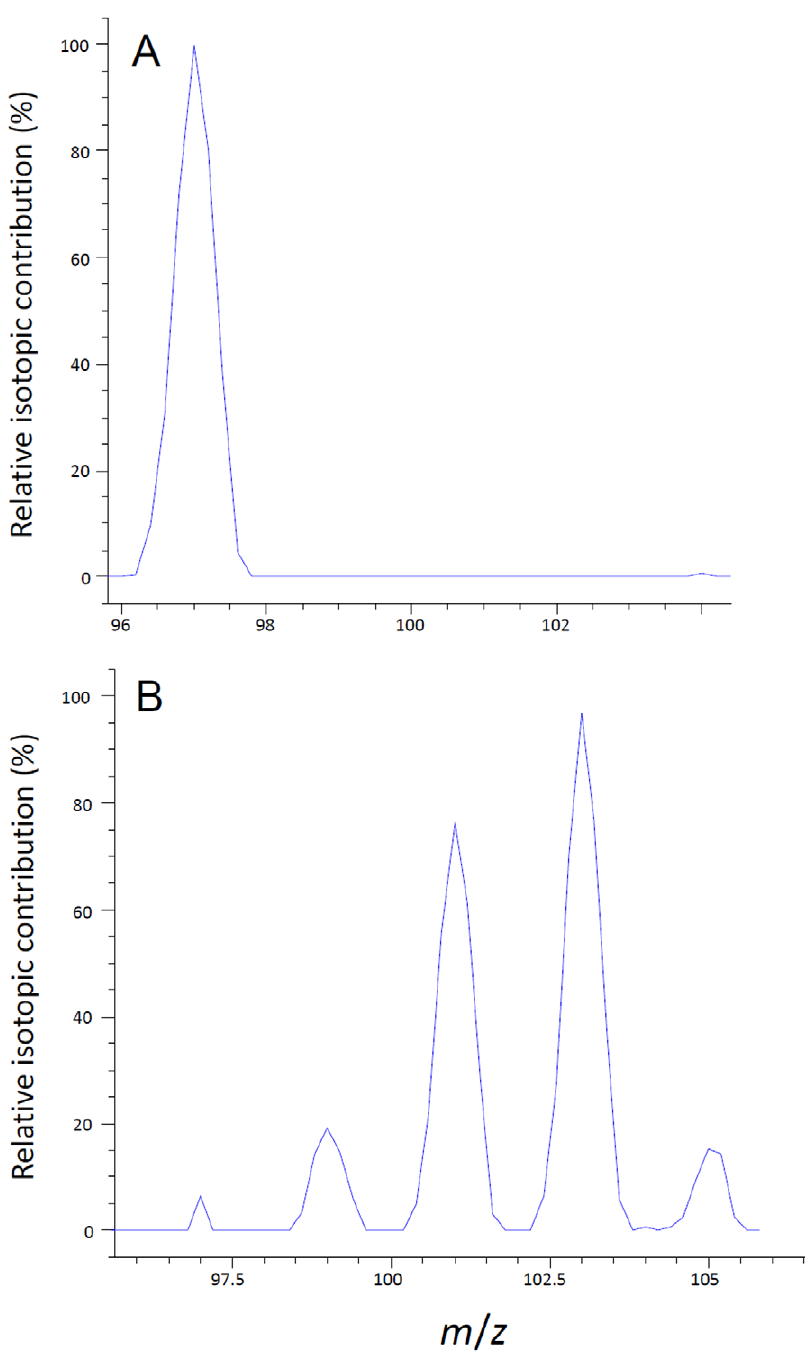
Figure 1. Electrospray ionization spectra of labeled and unlabeled phosphate species. Relative abundance of (a) unlabeled phosphate ( m/ z=97) and (b) 18 O-labeled phosphate species ( m/z =99, 101, 103, and 105) as determined by ESI-MS.